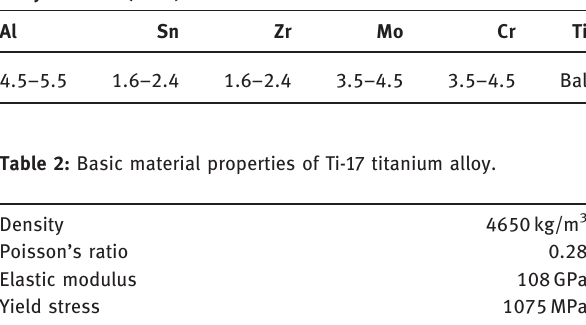
Table 1: Chemical compositions of Ti-17 titanium alloy. Alloy element (wt.%)